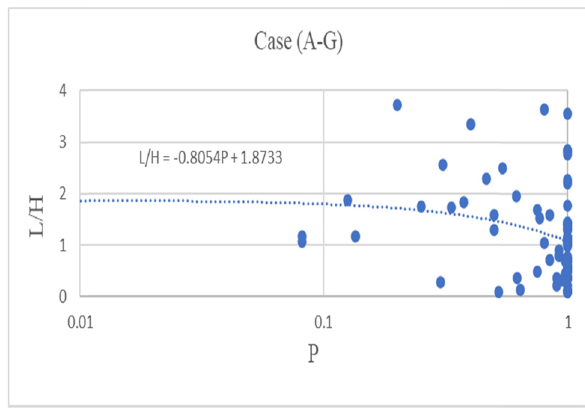
Figure 7: The relation of trunk length to upstream water head ( L / H ) to trap index ( p ) for cases ( A – G ) .